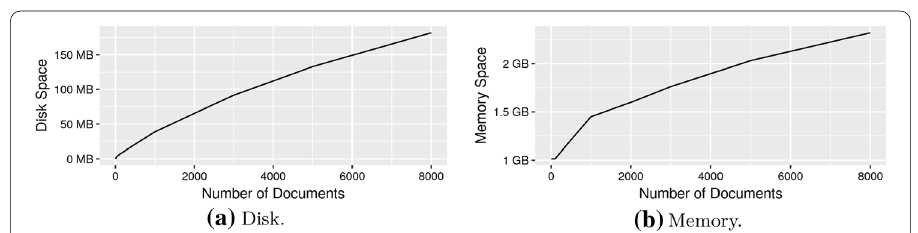
Fig. 9 Required space for storing and loading the base model over